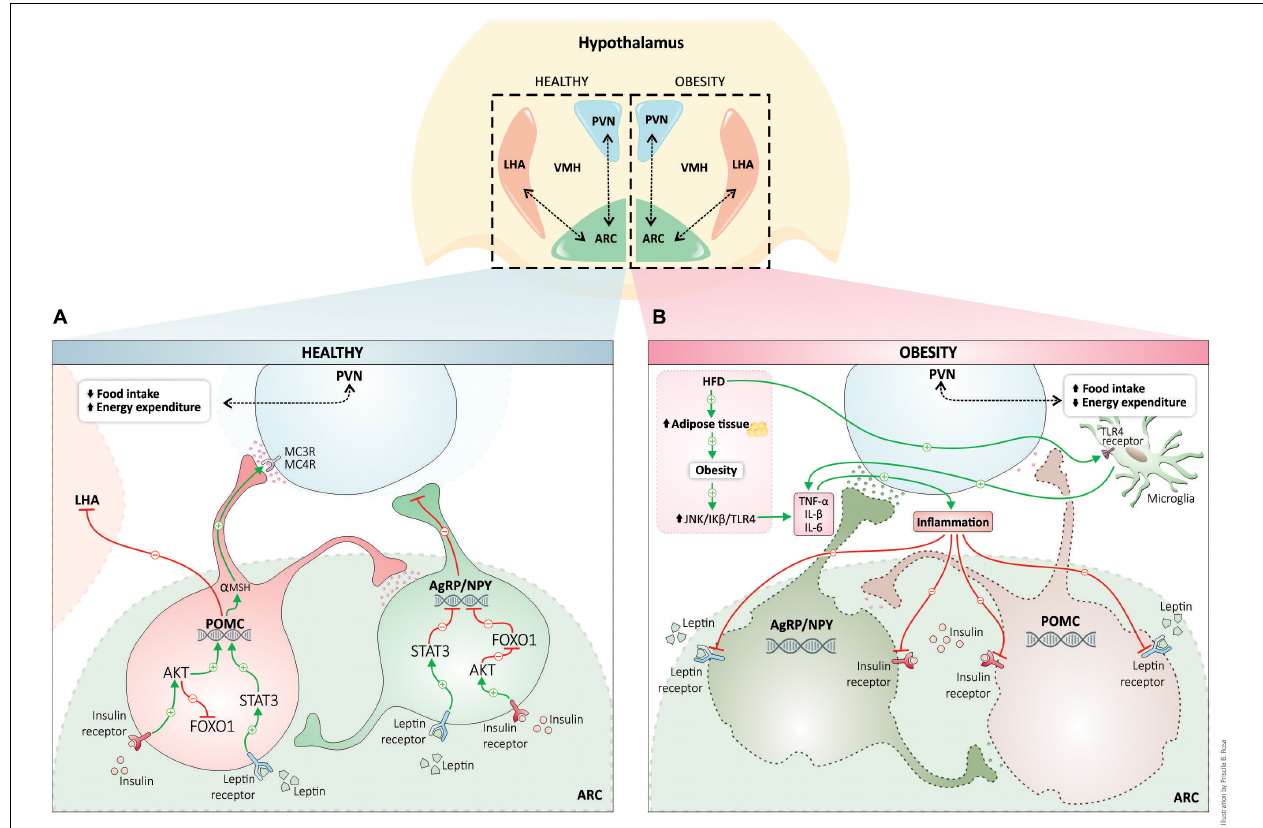
FIGURE 1 | Hypothalamic regulation of energy homeostasis in healthy (blue) and obesity (pink). The neuronal populations in the arcuate nucleus of the hypothalamus, POMC, and AgRP, senses and integrates peripheral adipostatic hormones (insulin and leptin), that circulate in levels proportionate to nutritional status and adipose tissue stores. Under the physiological postprandial state, insulin and leptin bind to respective receptors, both in POMC and AgRP neurons regulating the transcription of neuropeptides. Leptin and insulin signaling pathway stimulates POMC peptide transcription (activation of POMC neurons) and inhibits the transcription of AgRP neuropeptide (leading to AgRP neuronal inhibition). POMC neuronal activation involves the processing of POMC with the formation of α -MSH that is an agonist of MC4R in PVN neurons. PVN activation culminates in satiety (decreased food intake) and stimulation of energy expenditure (A) . High-fat diet consumption and obesity induces a whole-body chronic inflammatory state. Proinflammatory cytokines produced during inflammation are responsible for hypothalamic insulin and leptin resistance, and consequently, the neuronal control of energy homeostasis is disrupted inducing an increase in food intake and a decrease in energy homeostasis (B) . AgRP, agouti-related protein; Akt, protein kinase B; ARC, arcuate nucleus; FOXO1, forkhead box protein O1; IL-1 β , interleukin-1 β ; IL-6, interleukin-6; JNK, c-Jun N-terminal kinases; LHA, lateral hypothalamus; MC4R, melanocortin 4 receptor; NPY, neuropeptide Y; POMC, proopiomelanocortin; α -MSH, alpha-melanocyte-stimulating hormone; PVN, paraventricular nucleus; STAT3, Signal transducer and activator of transcription 3; TLR4, toll-like receptor 4; TNF- α , tumor necrosis factor- α ; VMH, ventromedial